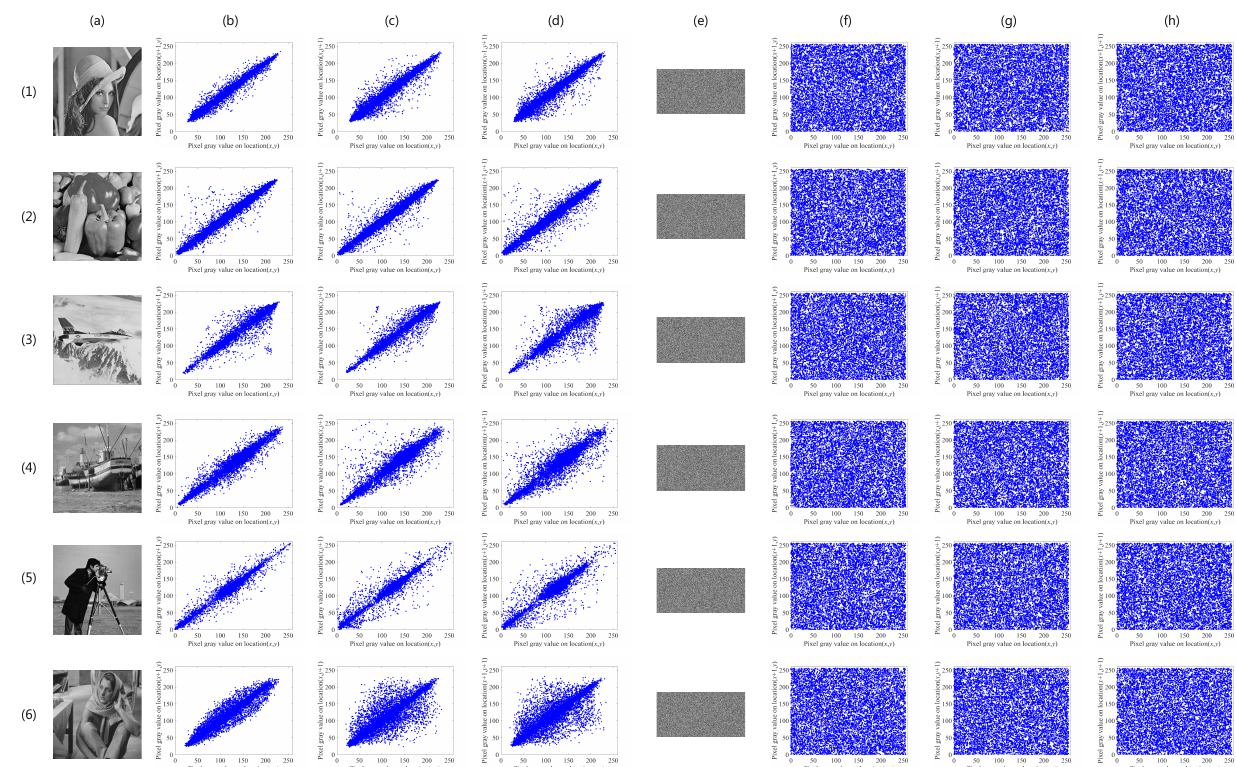
Figure 7. Correlation distributions. Rows ( 1 – 6 ) correspond to images of ’Lena’, ’Pepper’, ’Airplane’, ’Boat’, ’Cameraman’, and ’Barbara’, respectively; Column ( a ) shows the corresponding plain images; Columns ( b – d ) correspond to the plain images’ distributions of ’horizontal direction’, ‘vertical direction’, and ‘diagonal direction’, respectively; Column ( e ) is the corresponding cipher images by encryption; Columns ( f – h ) correspond to the cipher images’ distributions of ’horizontal direction’, ’vertical direction’, and ’diagonal direction’, respectively.